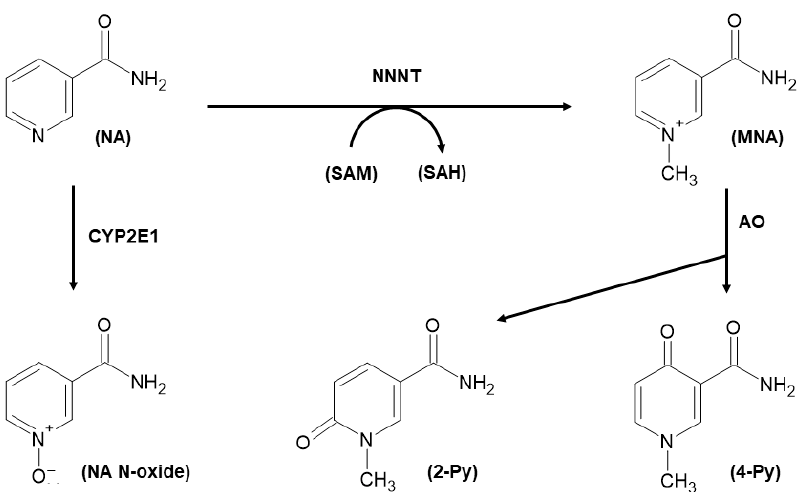
Figure 1. Nicotinamide (NA) catabolism through N-methylation and N-oxidation. NA is methylated by nicotinamide N-methyltransferase (NNMT), using the universal methyl donor S-adenosyl-L-methionine (SAM) that is converted to S-adenosyl-L-homocysteine (SAH). The methylated product N1-methylnicotinamide (MNA) can be further oxidized into N1-methyl-2-pyridone-5-carboxamide (2-Py), or N1-methyl-4-pyridone-3-carboxamide (4-Py), by aldehyde oxidase (AO). NA can be oxidized to nicotinamide N-oxide (NA N-oxide) by CYP2E1 enzyme. N-methylated and N-oxidized metabolites are excreted through urine.